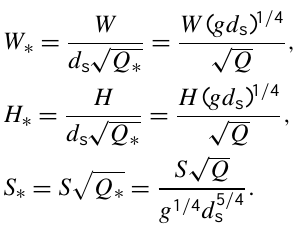
Figure 6. Aspect ratio ( W/H ) of the threads as a function of the di- mensionless water discharge ( Q ∗ ). Blue and red dashed lines show the average aspect ratio. Right: probability density functions.